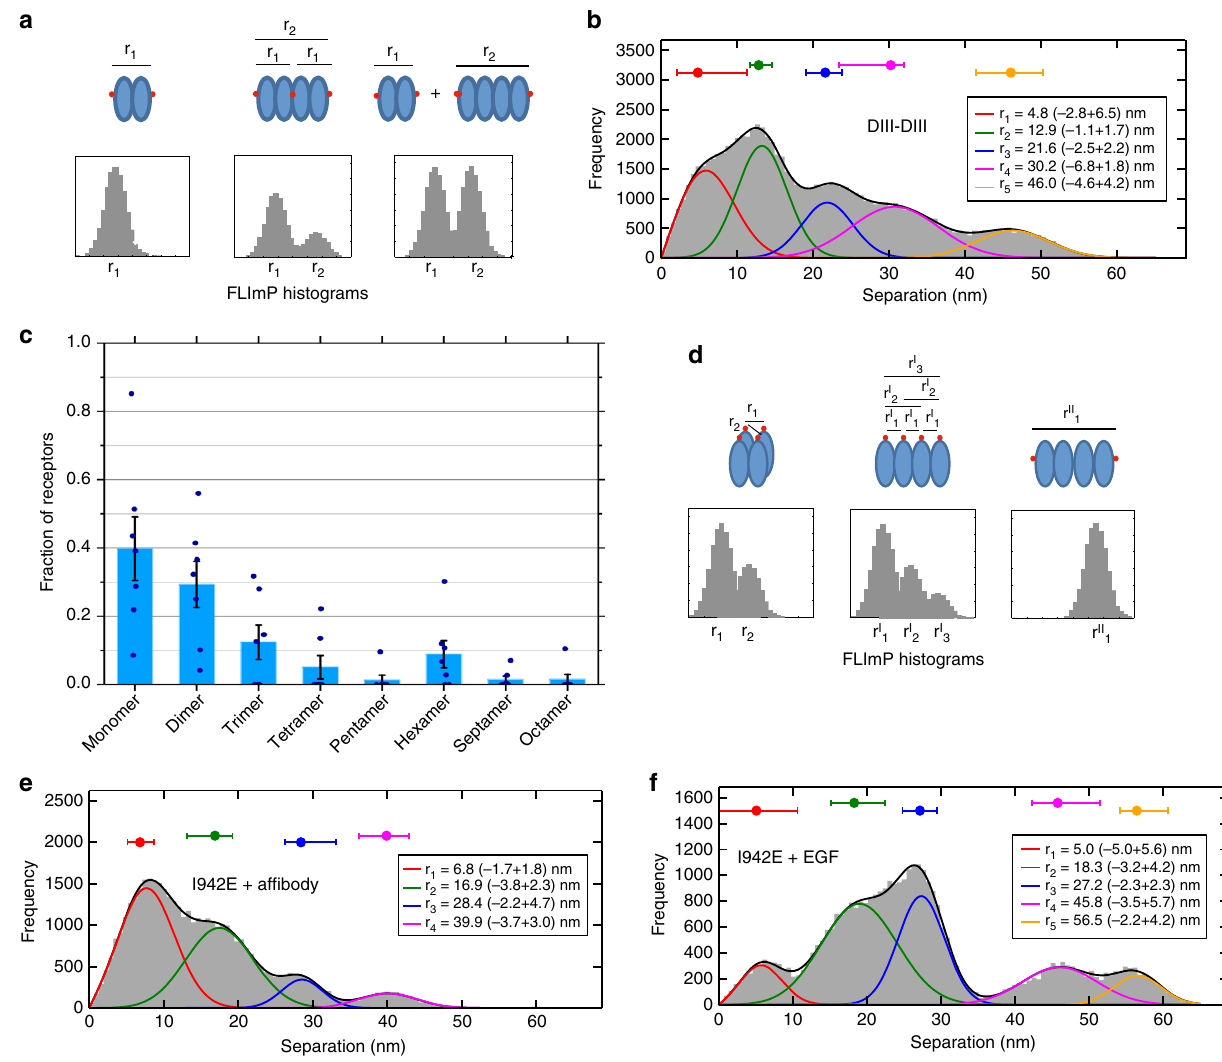
Fig. 2 FLImP measurement of pairwise DIII-binding Af fi body separations. a Cartoon of FLImP histograms. Left: A dimer (receptors, blue; label, red) gives rise to one separation, the empirical posterior of which has a con fi dence interval (CI) that depends on the combined localisation errors of the two molecules 28 . CI size determines resolution. CIs less than the required resolution are retained according to signal-to-noise without bias 12,28 – 30,36 , generating a FLImP distribution (grey) that is fi tted by the sum of a number of Rician peaks 12 . If oligomers are present and internally probed (middle) and/ or the distribution of species is inhomogeneous (right), the histogram contains multiple components 12 . b FLImP distribution (grey) of DIII – DIII separations between CF640R-Af fi body molecules bound to wtEGFR on CHO cells, compiled from 68 FLImP measurements (CI ≤ 7 nm), decomposed into a sum of fi ve components (coloured traces). The inset shows positions and error estimates. Additional statistics in Supplementary Fig. 1. The 4 nM concentration of CF640R-Af fi body used labels ~20% of receptors (Supplementary Fig. 2) ensuring single particle detection 29 . FLImP is stochastic, thus independent of the CF640R-Af fi body/receptor ratio if suf fi cient data are collected, and uses fi xed cells to avoid relative receptor movements during measurements. However, systematic studies failed to fi nd signi fi cant artifacts 12,36 . c Molecular-normalised fraction of receptors in oligomer species on wtEGFR-expressing CHO cells treated with 100 nM Alexa 488-Af fi body, determined by pbICS 38 . Results are the mean of seven replicates. Error bars show the SD. For more details see Supplementary Fig. 3. d Cartoon showing expected FLImP distributions for a cyclic tetramer labelled with a 1:1 probe binder (like the Af fi body) (left), a polymer chain labelled with a 1:1 probe binder (middle), and a polymer showing a 2N:2 labelling stoichiometry (like EGF) 12 ( N = receptor number) (right). e FLImP distribution (grey) and peak decomposition of DIII – DIII separations reported by CF640R-Af fi body molecules bound to I942E-EGFR on the surface of CHO cells, compiled from 36 FLImP measurements (CI ≤ 7 nm), decomposed into a sum of four peak components (coloured traces). Positions and error estimates are shown in the inset. f As e using 4 nM CF640R-EGF as a probe, compiled from 31 FLImP measurements (CI ≤ 7